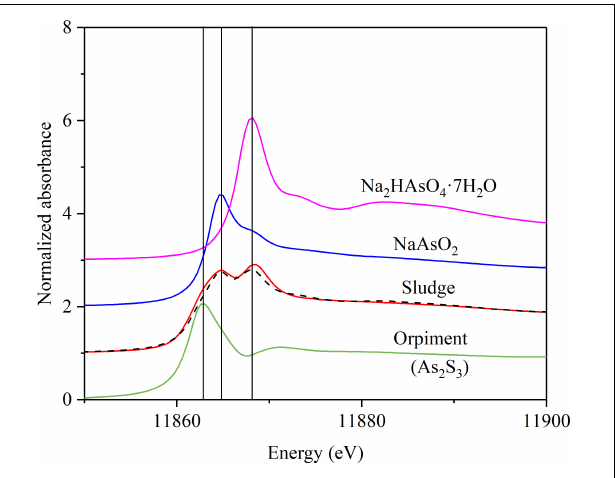
FIGURE 5 | Arsenic K- α X-ray absorption near edge structure spectra (XANES) from the sludge in the BES cathode chamber. The XANES spectra (red solid lines) for solid phase fit (black dashed lines) by least-squares linear combination to standards of Na 2 HAsO 4 · 7H 2 O [As (V), purple solid lines], NaAsO 3 [As(III)] (blue solid lines), and orpiment (As 2 S 3 ) (green solid lines); vertical lines indicate the diagnostic As species position ( ± 1 eV): 11,863 = arsenic sulfide; 11,864.6 = As(III); 11,868.2 = As (V). Fits and reported error are given in Supplementary Table 5